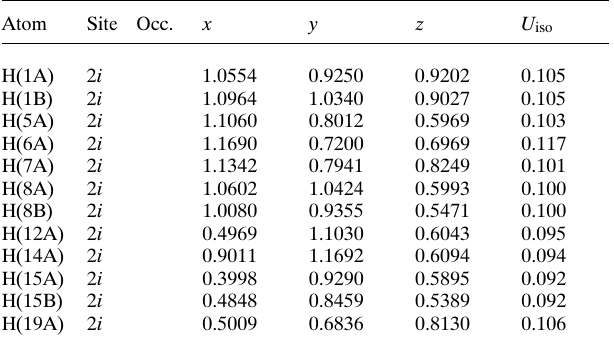
Table 2. Atomic coordinates and displacement parameters (in Å 2 ) .